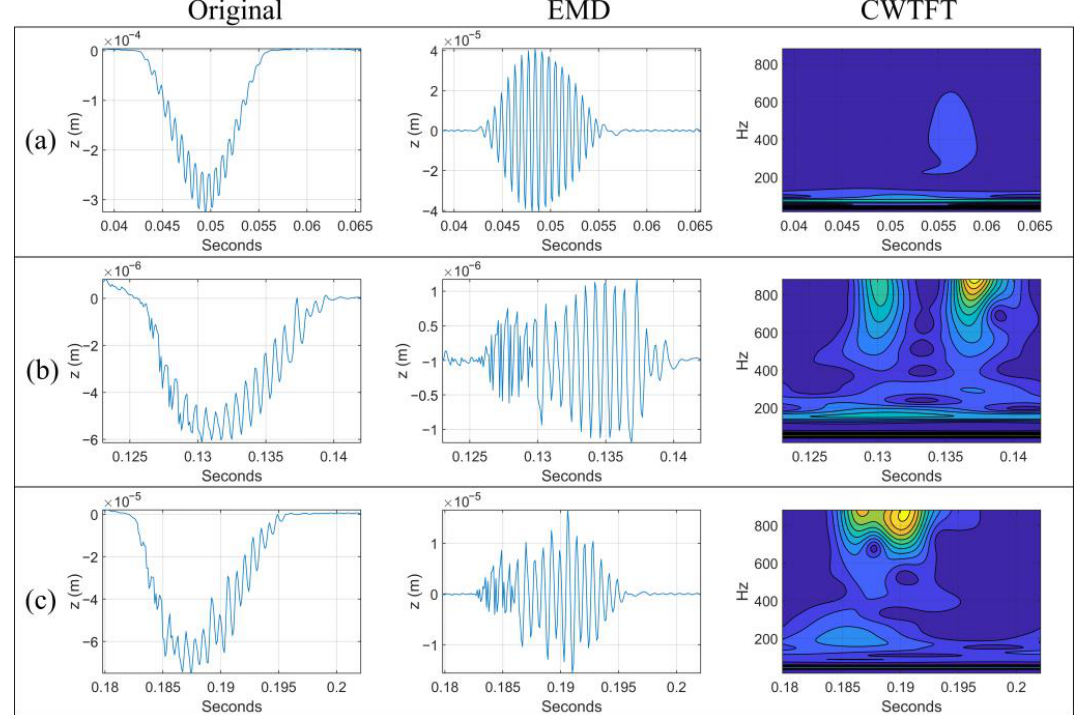
Figure 18. Time and frequency response of the rail in the vertical direction at different locations: ( a ) n 214 , ( b ) n 542 , and ( c ) n 790 . Only the first IMF was